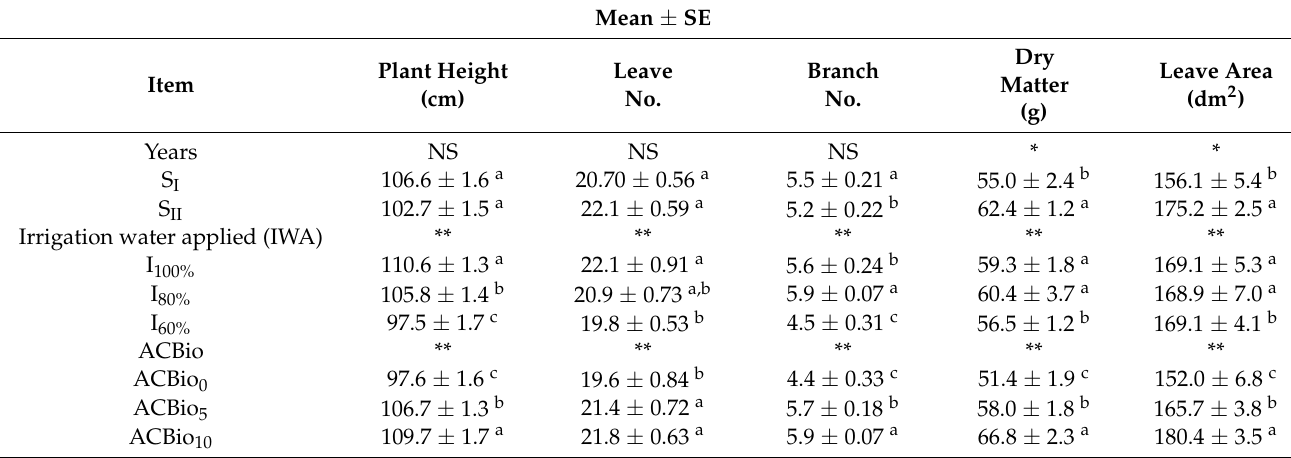
Table 5. Means and standard errors for plant height, leaf number, branch number, dry matter, and leaf